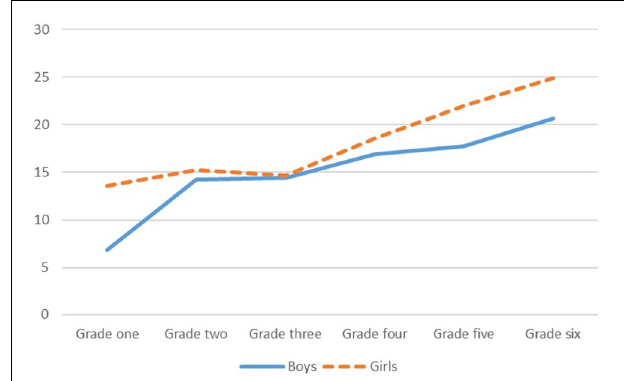
FIGURE 2 | Variation trend of overall gender equality awareness in different grades.